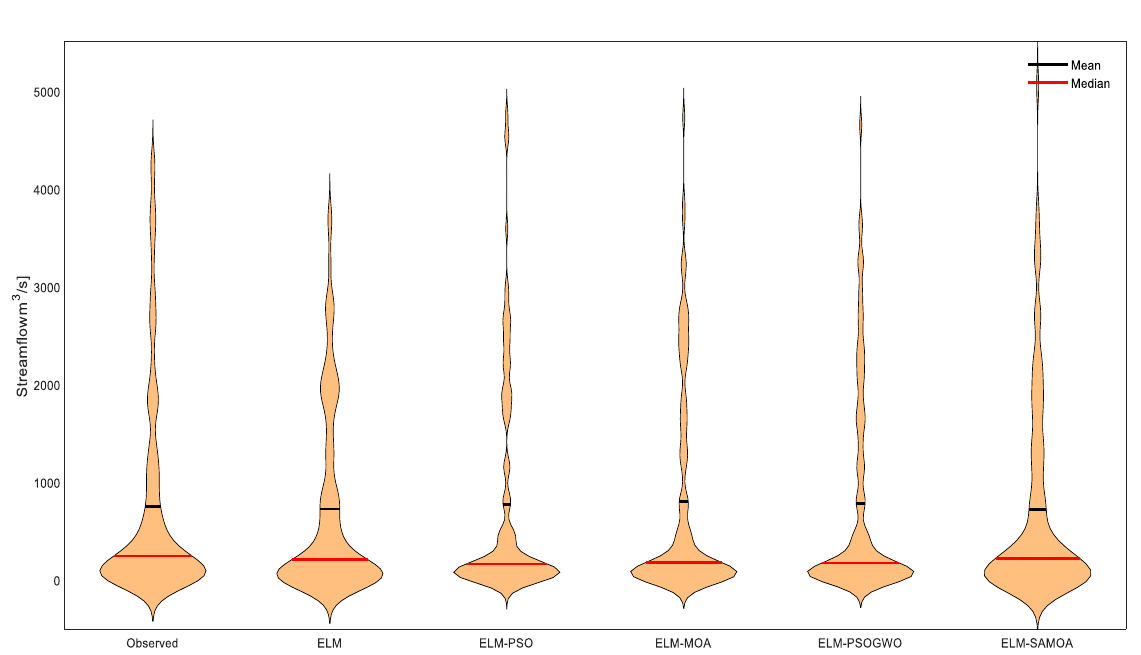
Fig. 10 Taylor and violin diagrams of different ELM-based models in the test period of Gorai